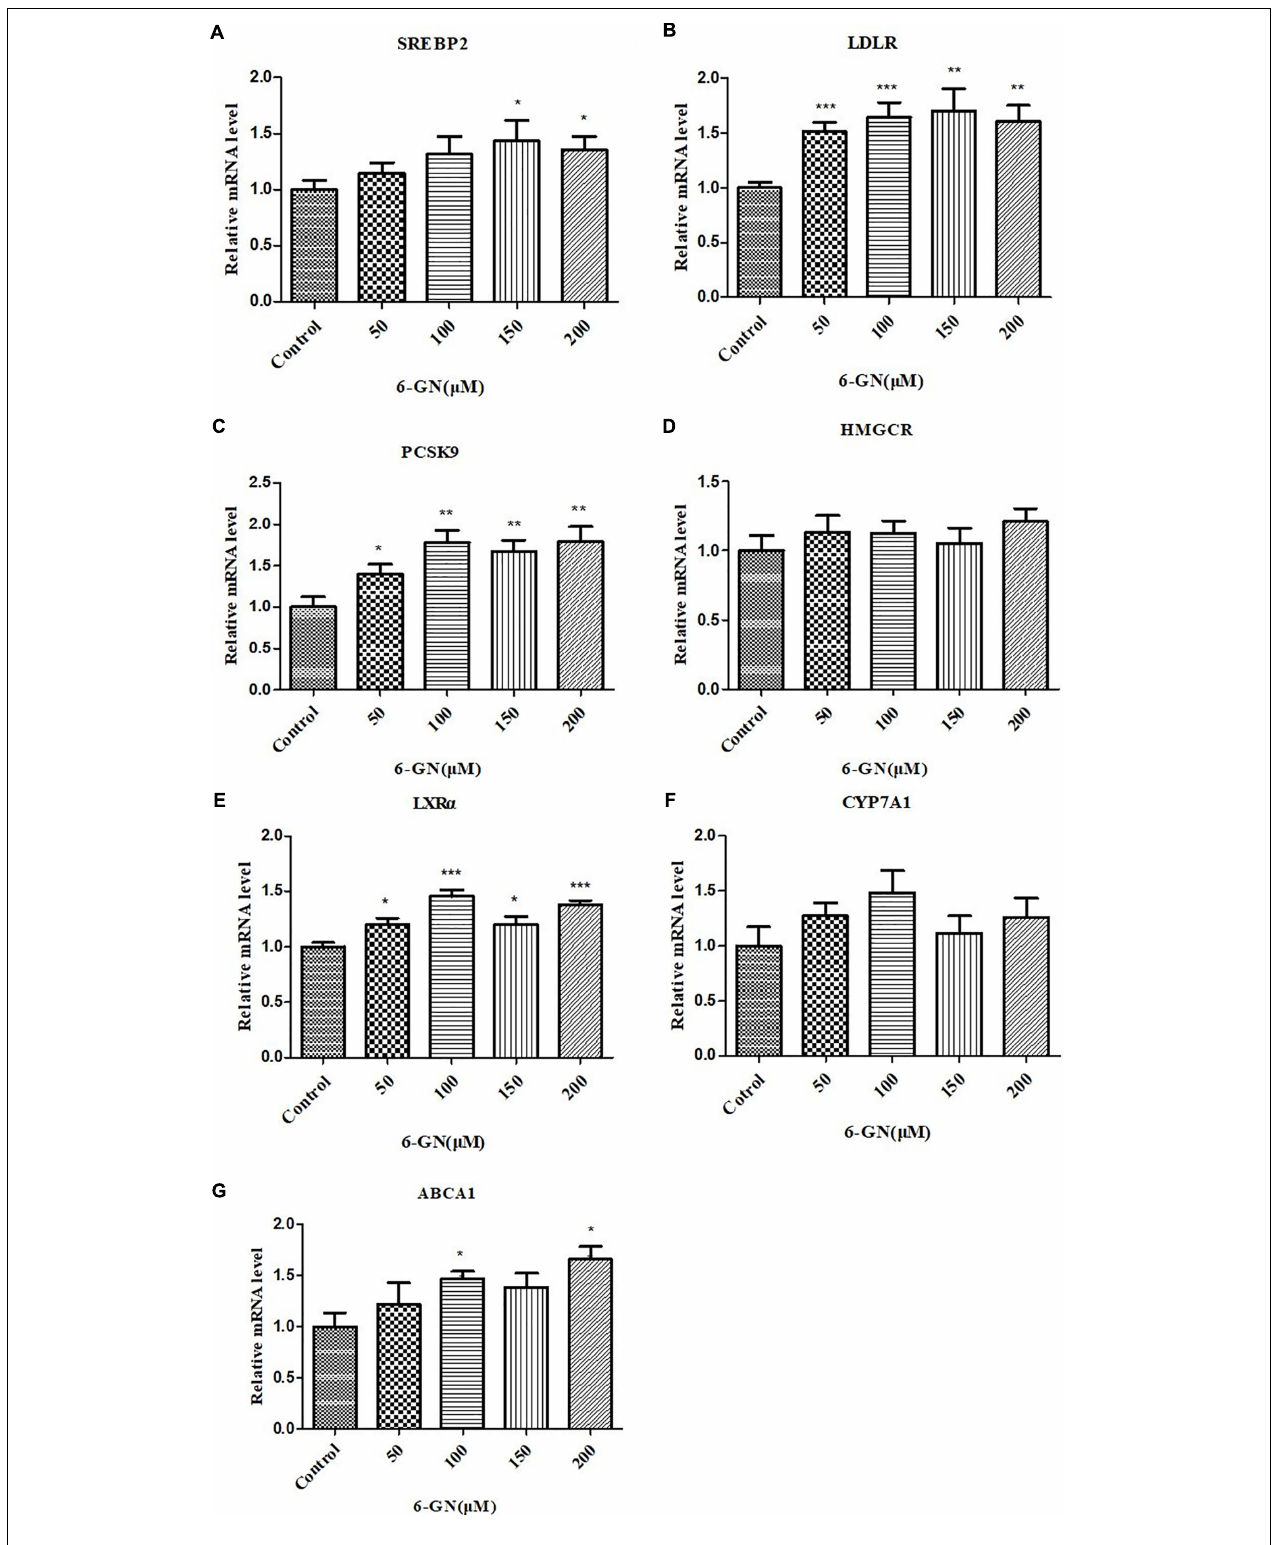
FIGURE 4 | Effect of 6-GN on relative mRNA levels of (A) SREBP2, (B) LDLR, (C) PCSK9, (D) HMGCR, (E) LXR α , (F) CYP7A1, and (G) ABCA1 in HepG2 cells. HepG2 cells were disposed with or without various concentrations of 6-GN (50, 100, 150, and 200 µ M) for 24 h. Values were represented as mean + SD of three independent experiments. ∗ p < 0.05 versus control, ∗∗ p < 0.0l versus control, ∗∗∗ p < 0.001 versus control.